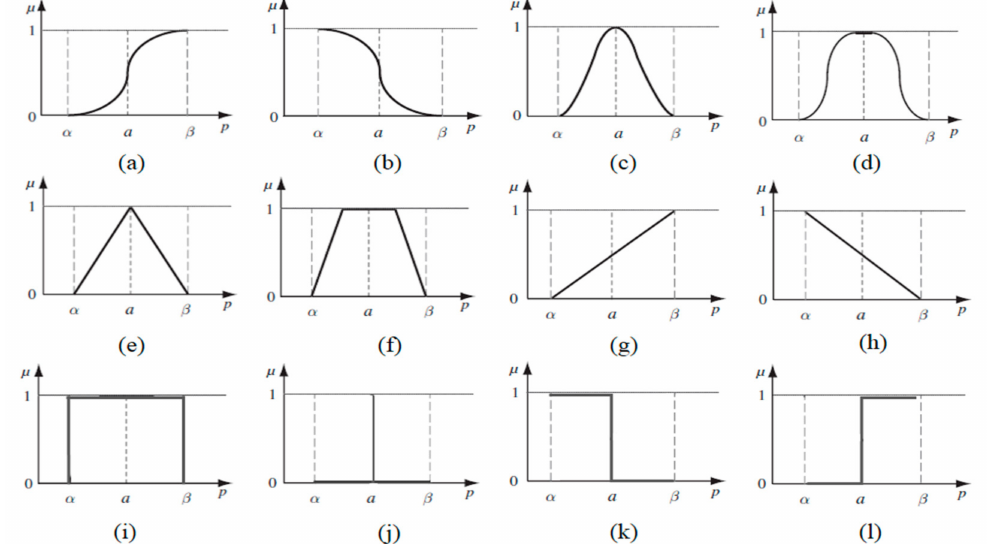
Figure 6. Typical representatives of fuzzy membership functions with p as the describing property and µ as the degree of membership. Displayed are: ( a ) larger than, ( b ) smaller than, ( c ) Gaussian, ( d ) about range, ( e ) linear range (triangle), ( f ) linear range (triangle inverted), ( g ) larger than (linear), ( h ) smaller than (linear), ( i ) full range, ( j ) singleton, ( k ) smaller than (Boolean-crisp), and ( l ) larger than (Boolean-crisp)